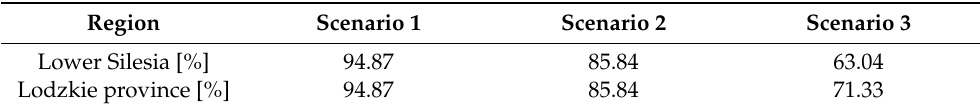
Table 4. Emission reduction of primary PM 2.5 results in the household sector in Lower Silesia and Lodzkie